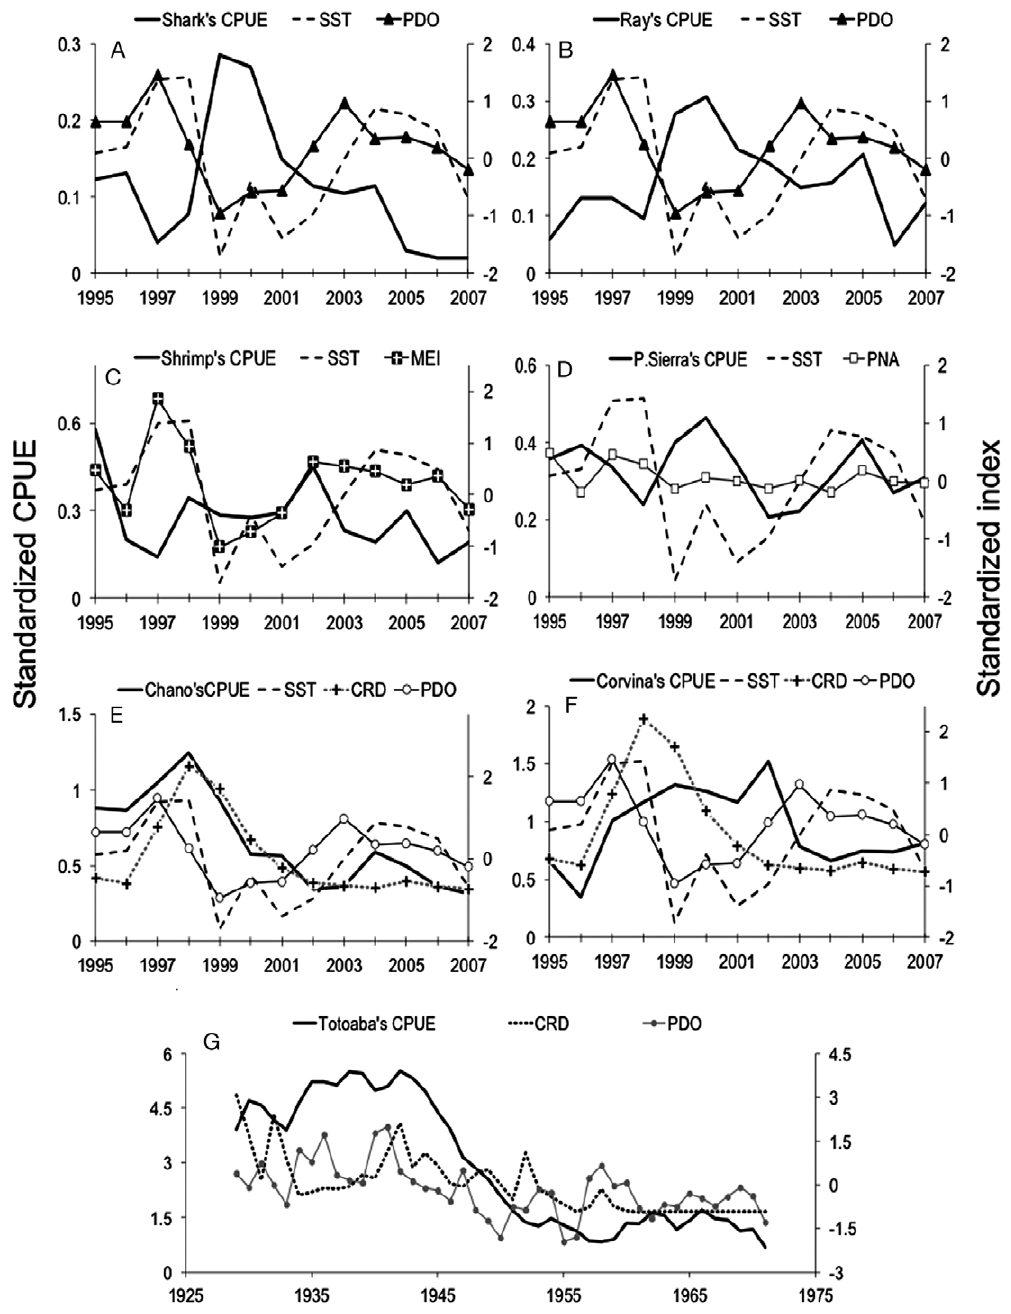
Fig. 4. – Standardized time series of CPUE values and statistically significant environmental variables resulting from GAM for shark (A), ray (B), blue shrimp (C), Pacific sierra (D), chano (E), corvina (F) and totoaba